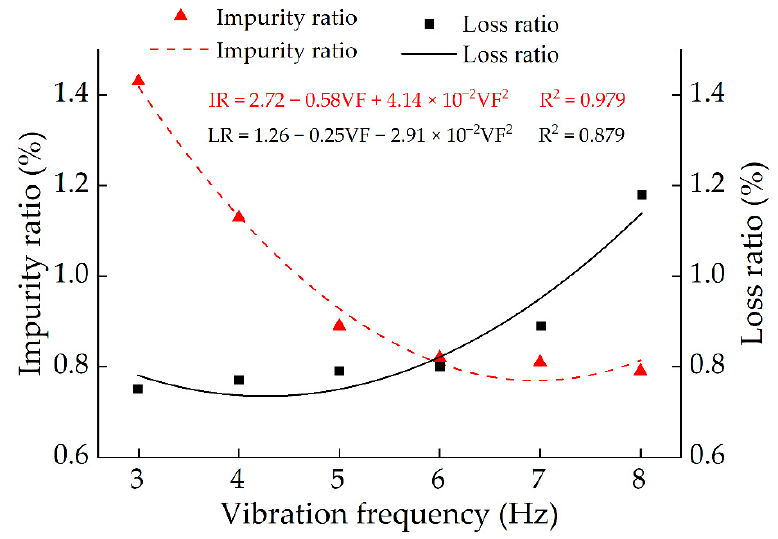
Figure 7. Influence of vibration frequency on the impurity ratio and loss ratio.